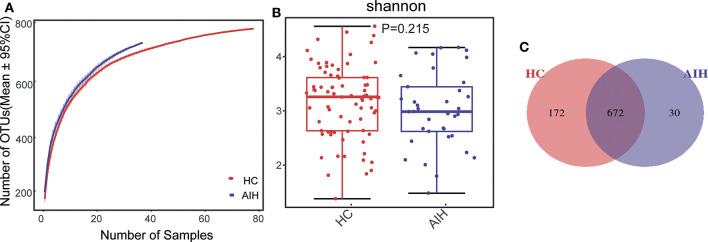
Relative reduction of fecal microbial diversity in patients with AIH (N = 37) and HCs (N = 78). (A) Specaccum species accumulation curves for number of samples and estimated richness. Estimated OTU richness approached saturation in all samples. Fecal microbial diversity estimated by Shannon index (B) was significantly decreased in patients with AIH (blue) compared with HCs (red). (C) Venn diagram displaying overlaps between groups showed that 672 of the 874 OTUs were shared between the AIH (blue) and HCs (red) groups. Thirty of the 874 OTUs were unique to AIH. AIH, autoimmune hepatitis; HCs, healthy controls; OTUs, operational taxonomic units. Significant differences by *P < 0.05; **P < 0.01, ***P < 0.001.